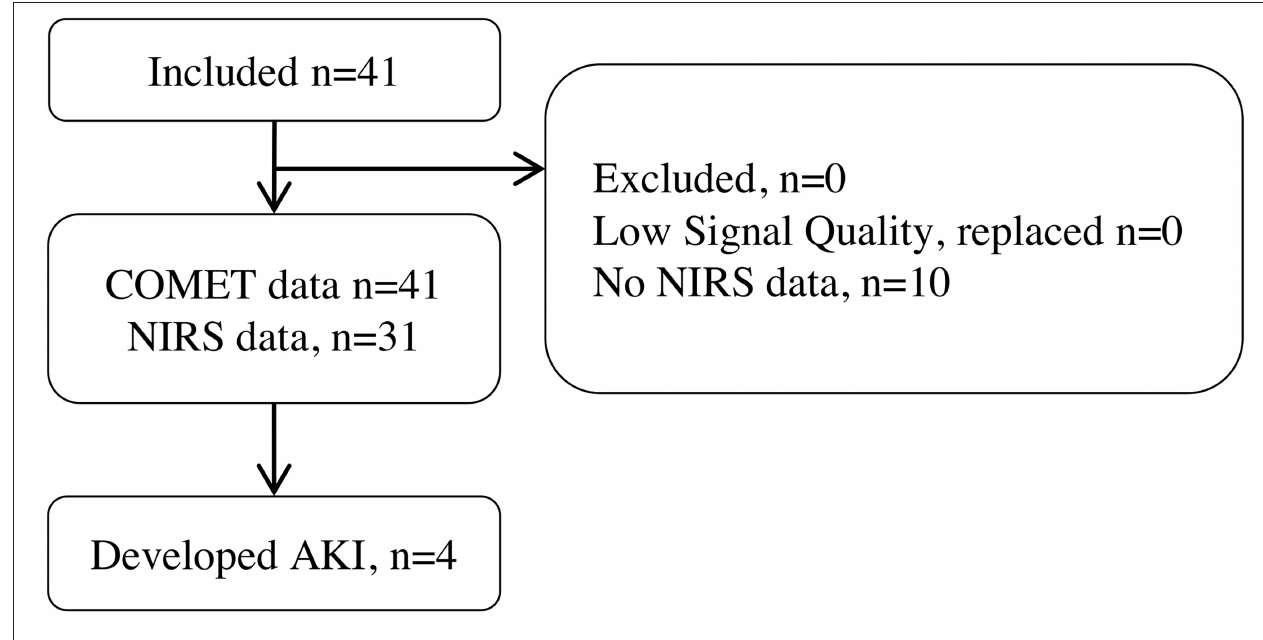
FIGURE 2 | Patient study flowchart.